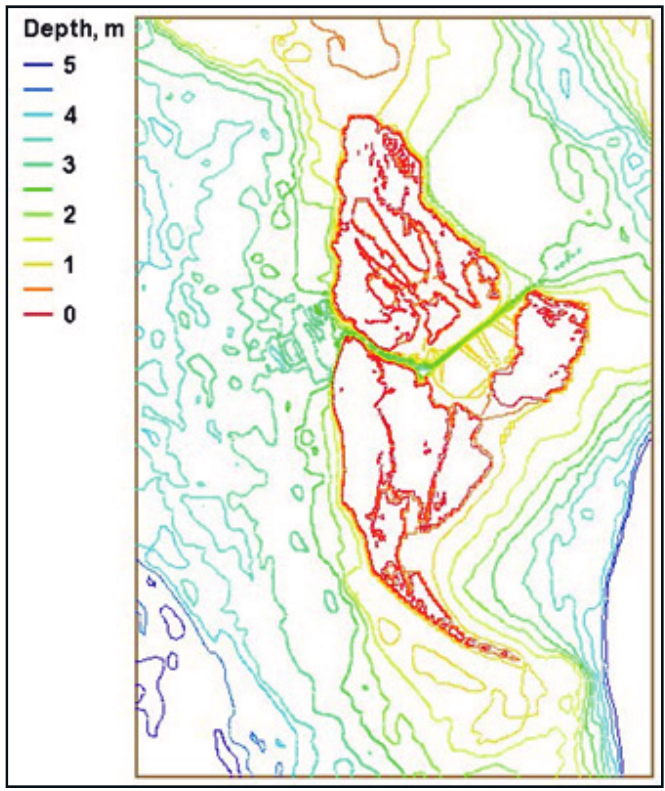
Figure 2. Depth contours in the boat canal crossing through the mid-section of Tangier